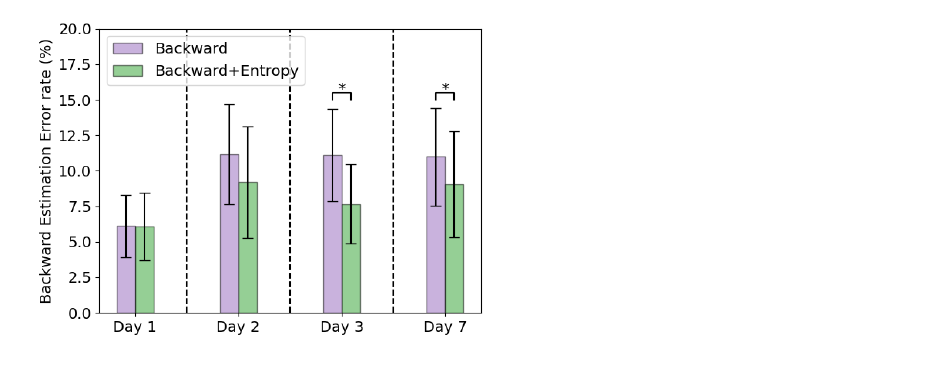
Figure 9. Average error rates with standard deviation of the backward prediction error of the backward predictor and the backward predictor with entropy adaptation. Asterisk indicates signifi- cant